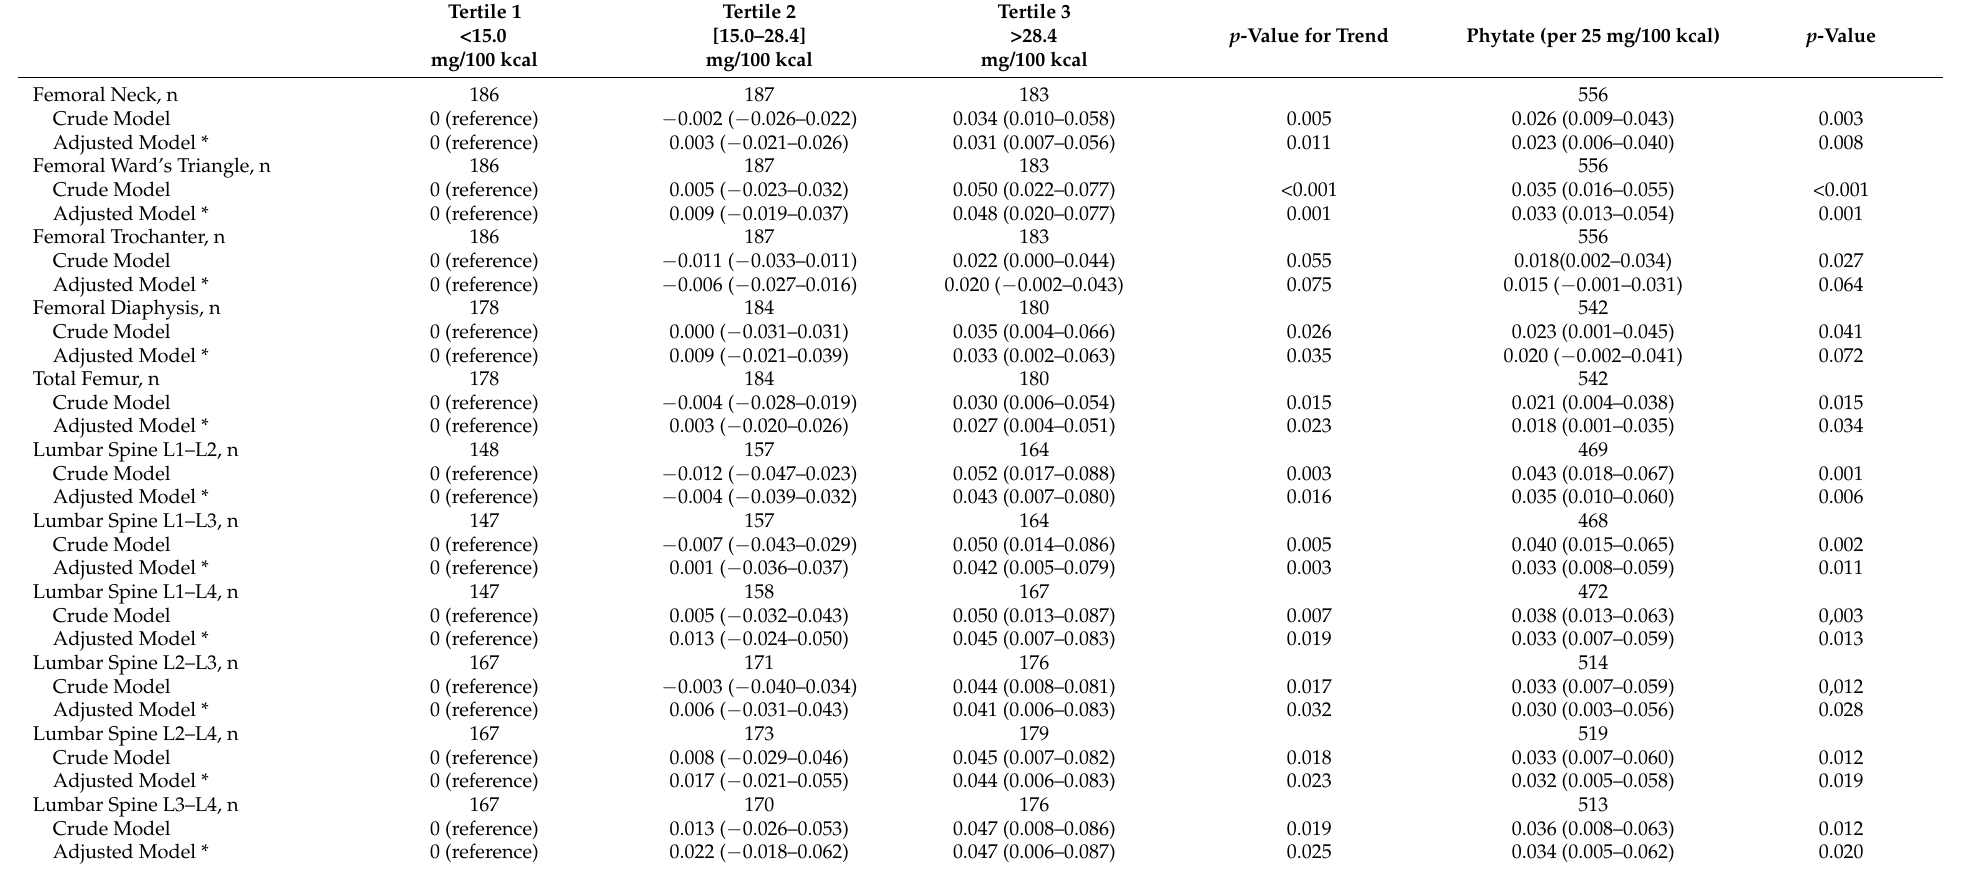
Table 4. Association of bone mineral density (g/cm 2 ) with estimated phytate intake (by tertiles and per each 25 mg/100